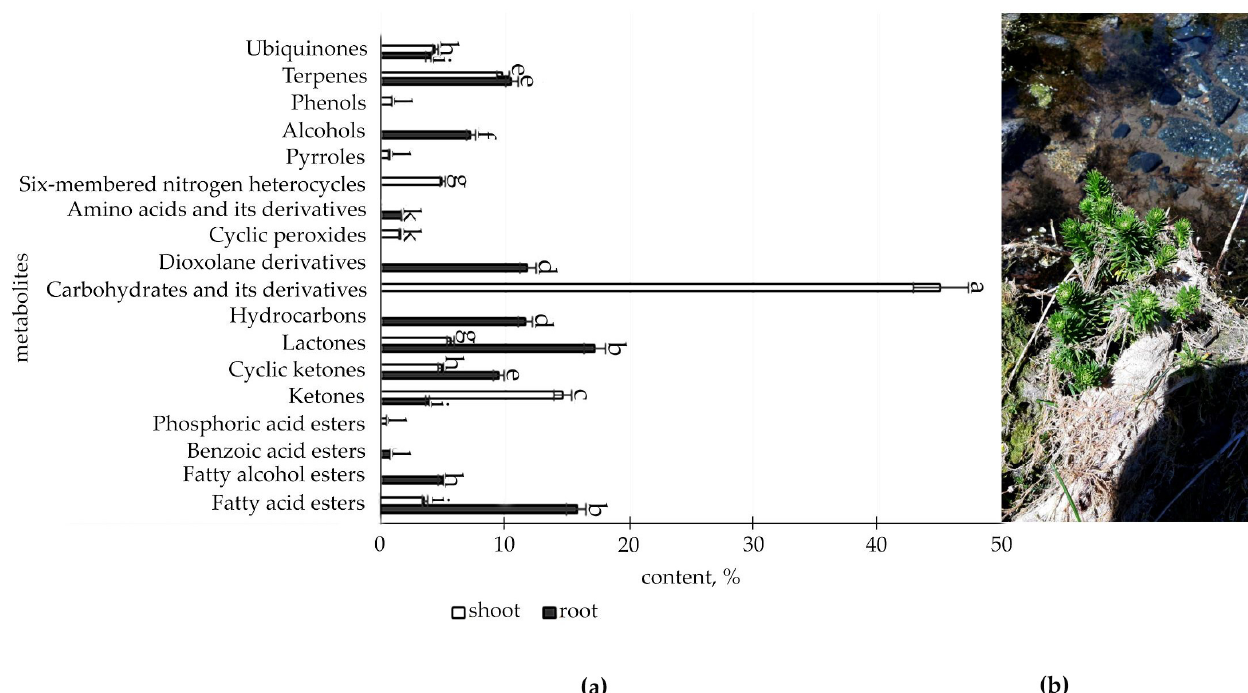
Figure 1. ( a ) Content of secondary metabolites classes of immature plants R. semenovii , %. Values presented are means (± SD). Different letters above the bars represent significant differences at p ≤ 0.05, n = 3 plants in each of 3 replicates for all treatments; ( b ) immature plants R. semenovii .